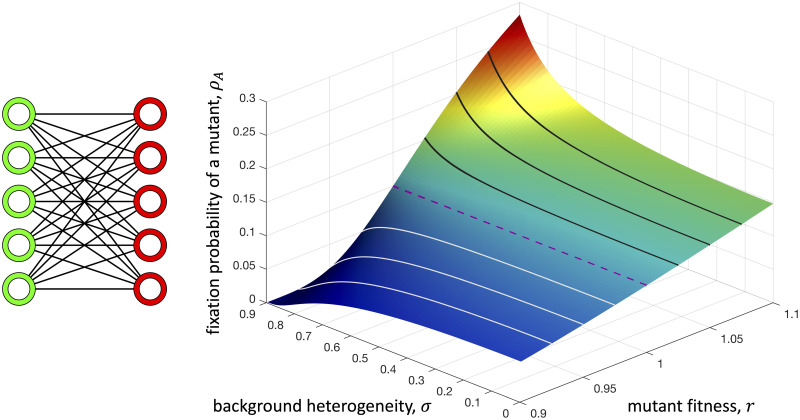
Effects of background heterogeneity on a complete bipartite graph with NG = NR = 5.Background heterogeneity increases the fixation probability of an advantageous mutant (black lines) and decreases that of a disadvantageous mutant (white lines). These effects are monotonic in background heterogeneity, σ. By Theorem 1, this behavior is identical to that of a regular (not necessarily complete) properly two-colored graph with equal numbers of green and red nodes.